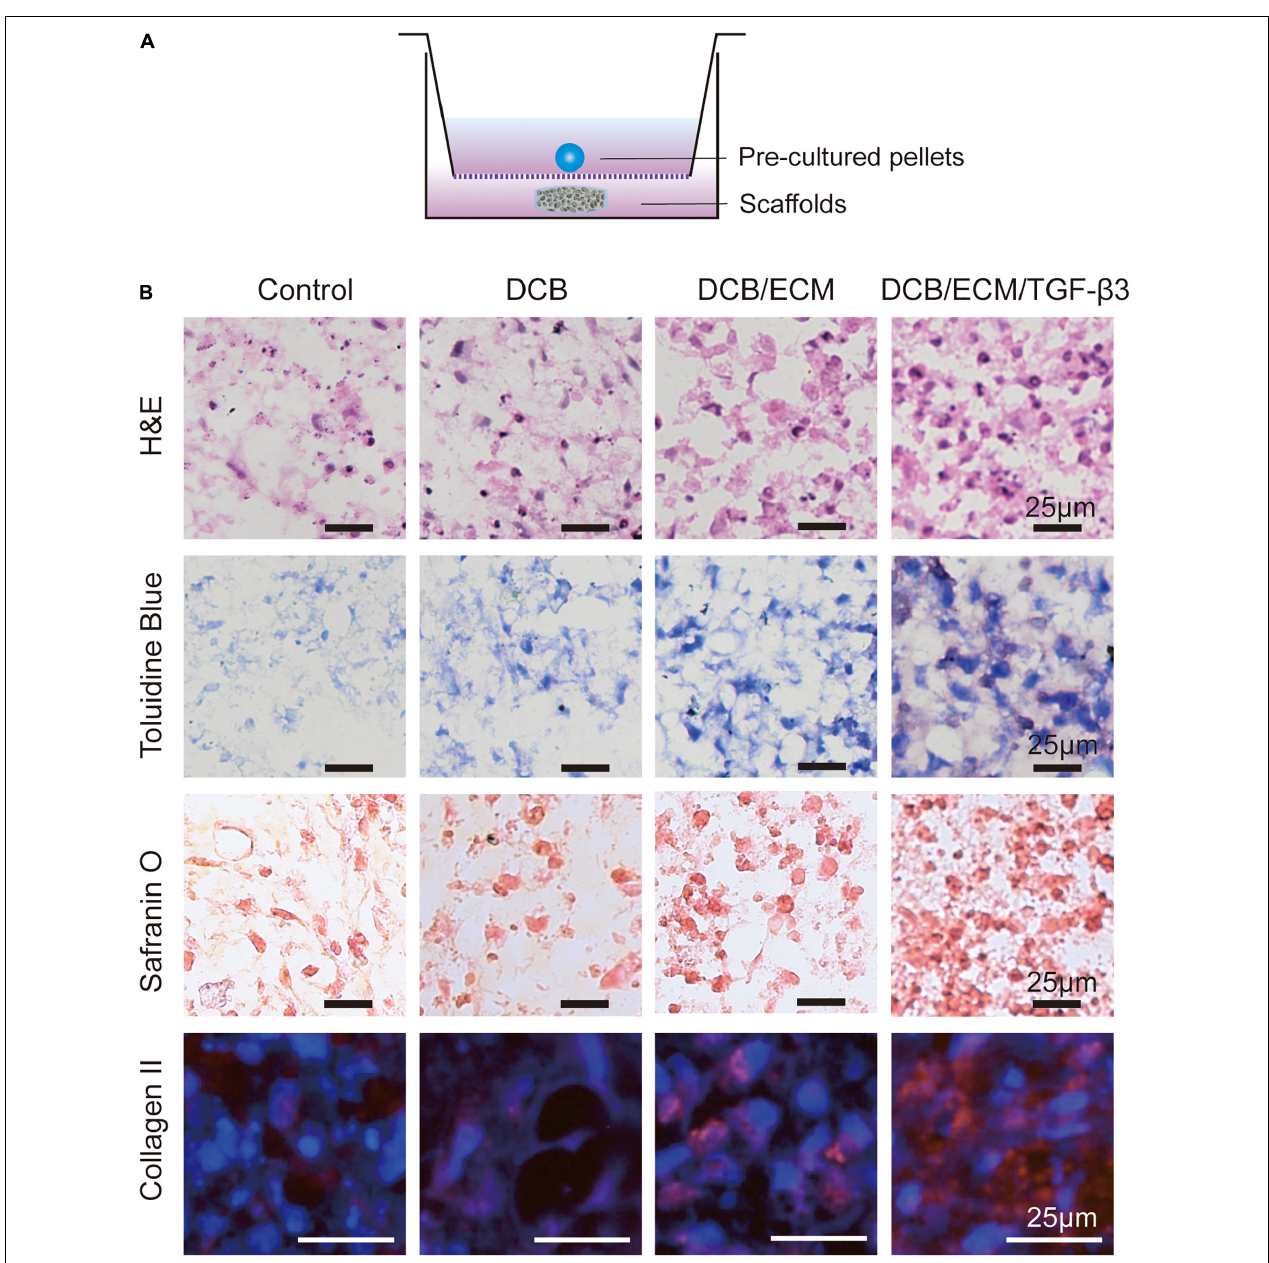
FIGURE 5 | Chondrogenic capacity of the different scaffolds in vitro . (A) Schematic illustrations of the coculture systems between pre-cultured pellets and the different scaffolds. (B) Histological and immunofluorescence analyses of chondrogenic pellets performed in a coculture system with different scaffolds. H&E, toluidine blue, safranin O, and collagen II immunofluorescence staining were